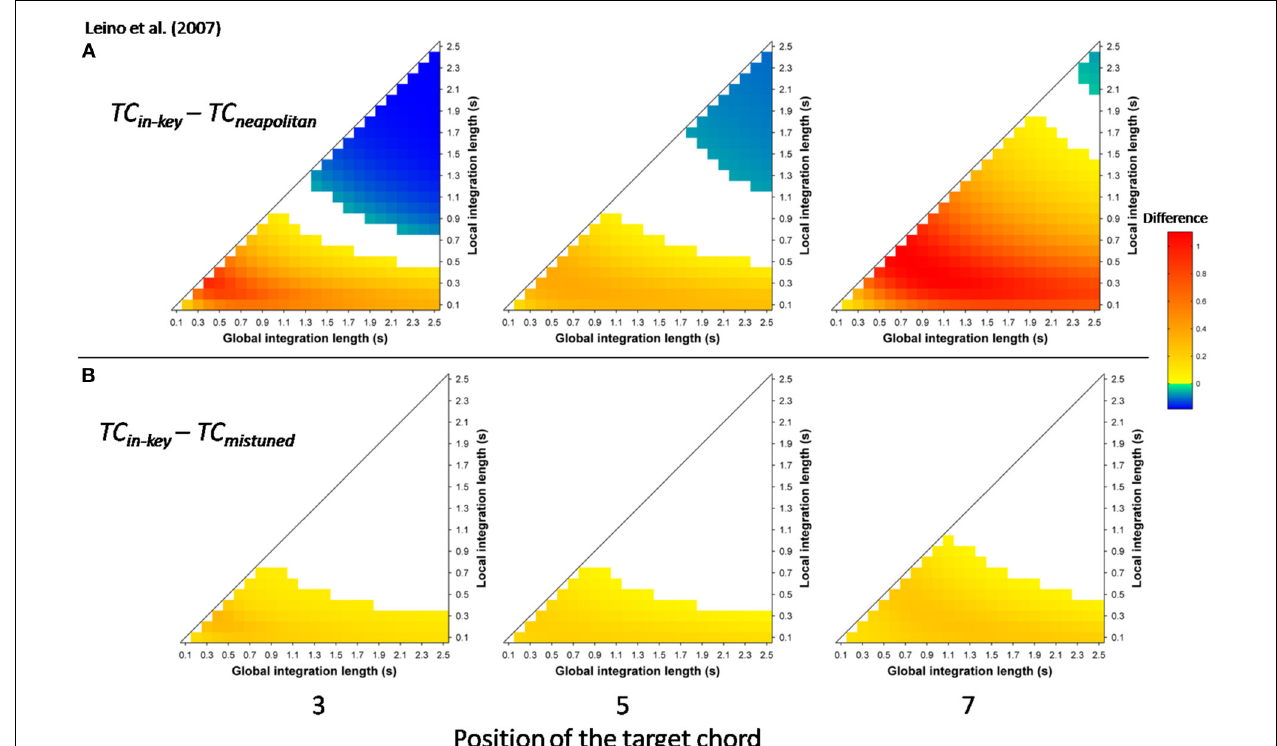
FIGURE 7 | Simulation data obtained with the stimuli of Leino et al. (2007). Mean TC differences (200 ± 25ms after onset) as a function of the local and global context integration windows between in-key targets vs. Neapolitan chords (A) , in-key targets vs. mistuned (but in-key) chords (B) .